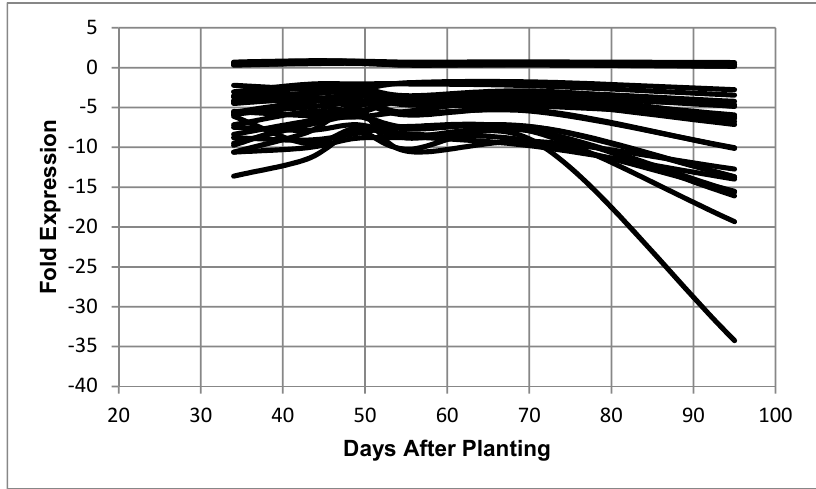
and S17 ( − 24.51). Int. J. Mol. Sci. 2018 , 19 , x FOR PEER REVIEW